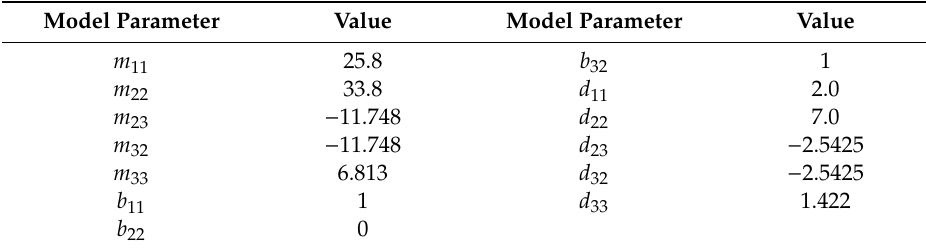
Table 1. Model parameters of